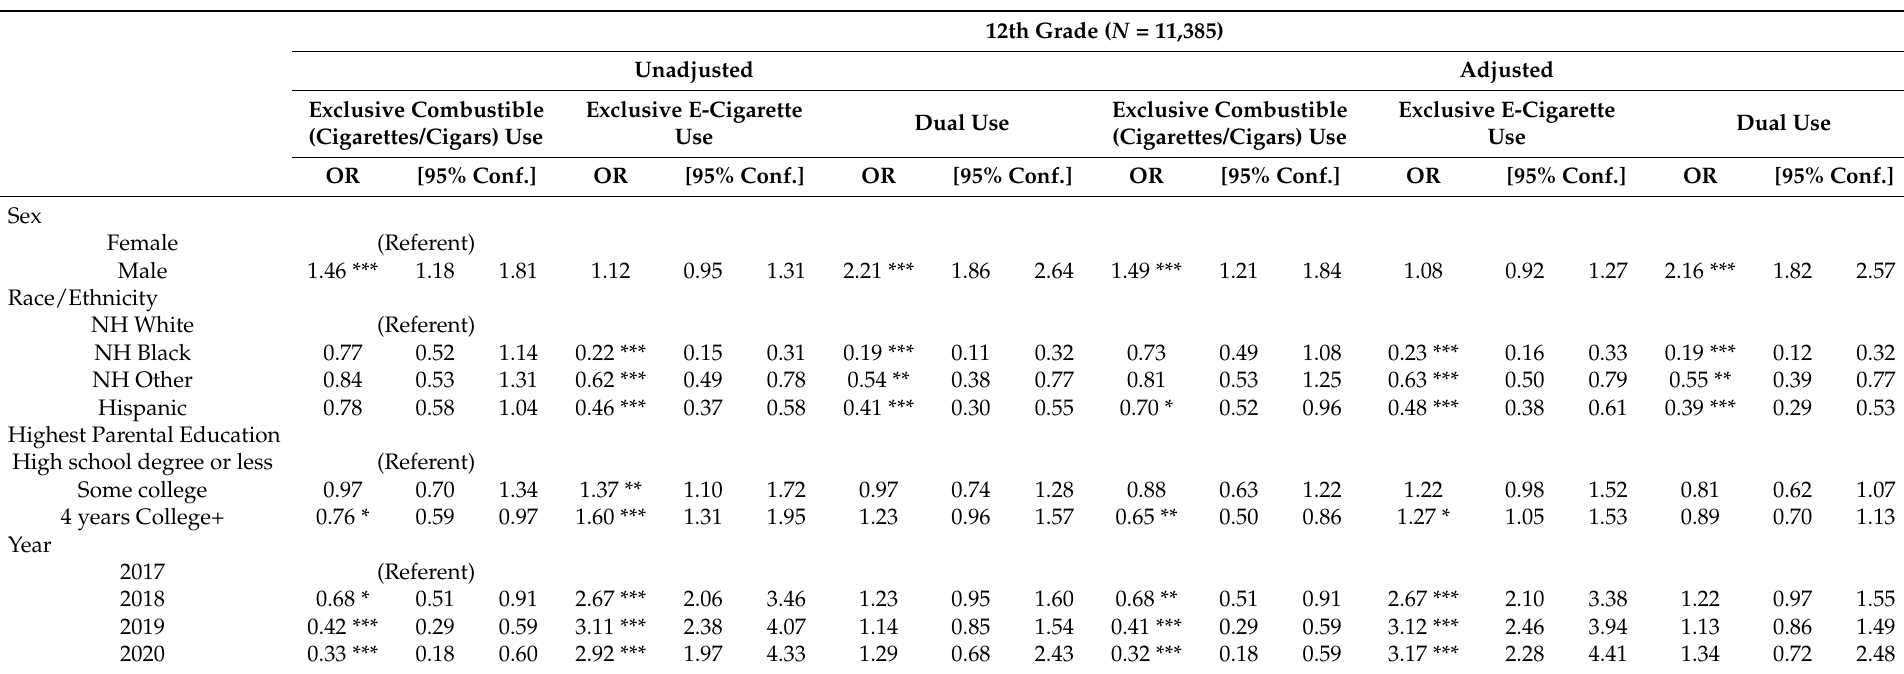
Table 4. Multinomial Regression Models of Sociodemographic Factors associated with Exclusive and Dual use of E-cigarettes with Combustibles (cigarettes and cigars) among twelfth graders: Monitoring the Future Surveys, 2017 to